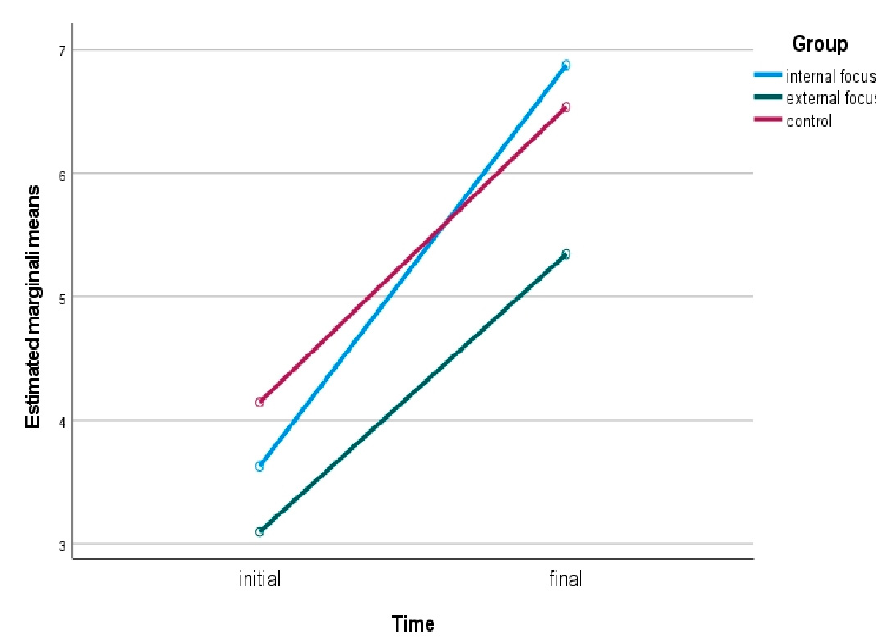
Figure 2. Initial and final pain perception among the groups.